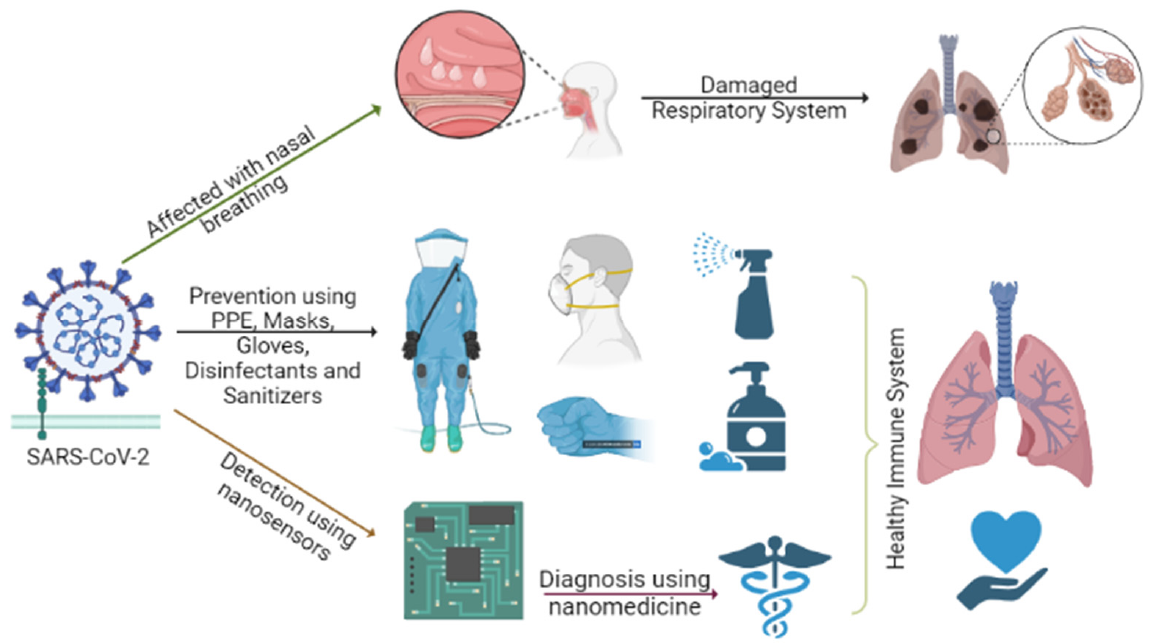
Figure 6. Prevention, detection, and diagnosis of SARS ‐ CoV ‐ 2.